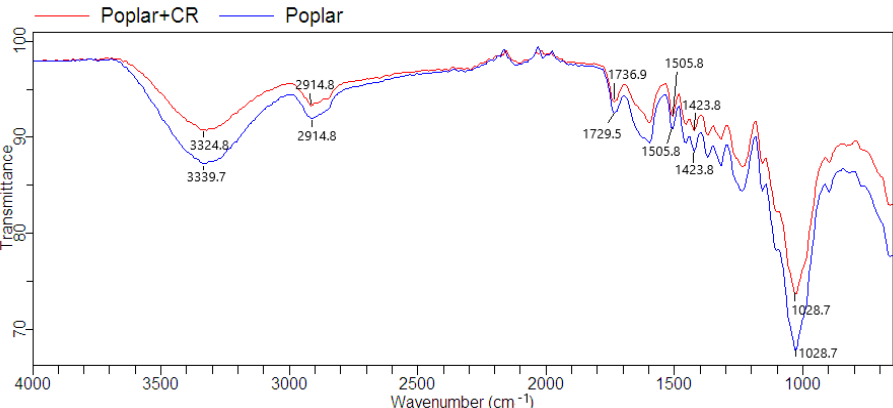
Figure 4. The Fourier transform infrared spectroscopy (FTIR) spectral characteristics of EP before and after CR biosorption.